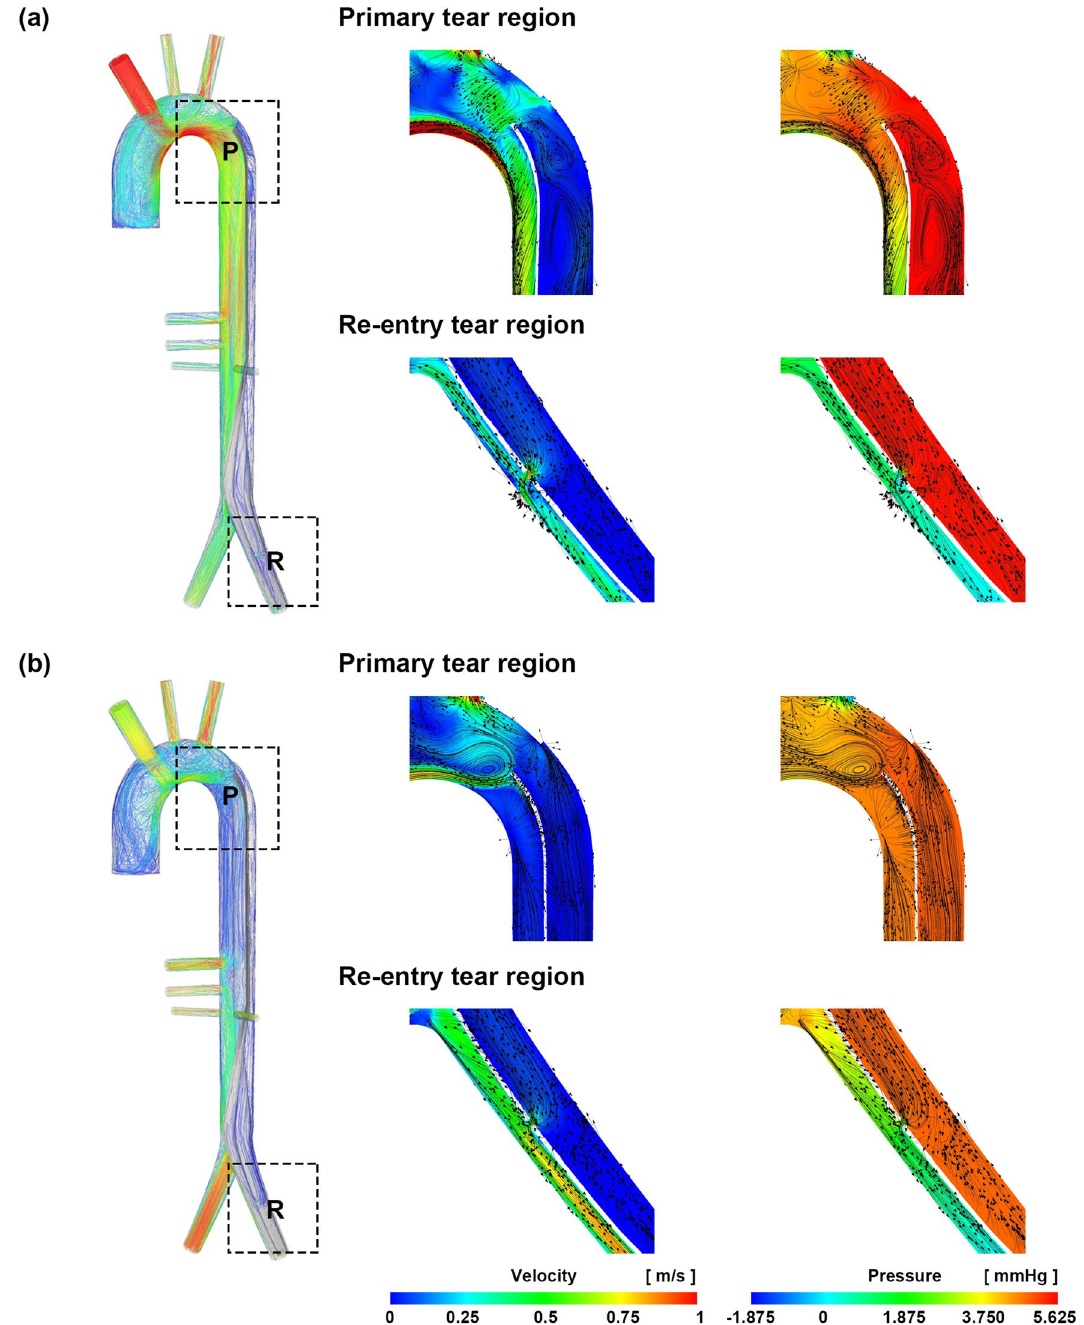
Figure 4. Characteristics of the tear regions for AC and AFC. ( a ) AC 7 L/min and ( b ) AFC 7 L/min. These images were made with Ensight (v.2021 R1, https:// www. ansys. com) using the FSI